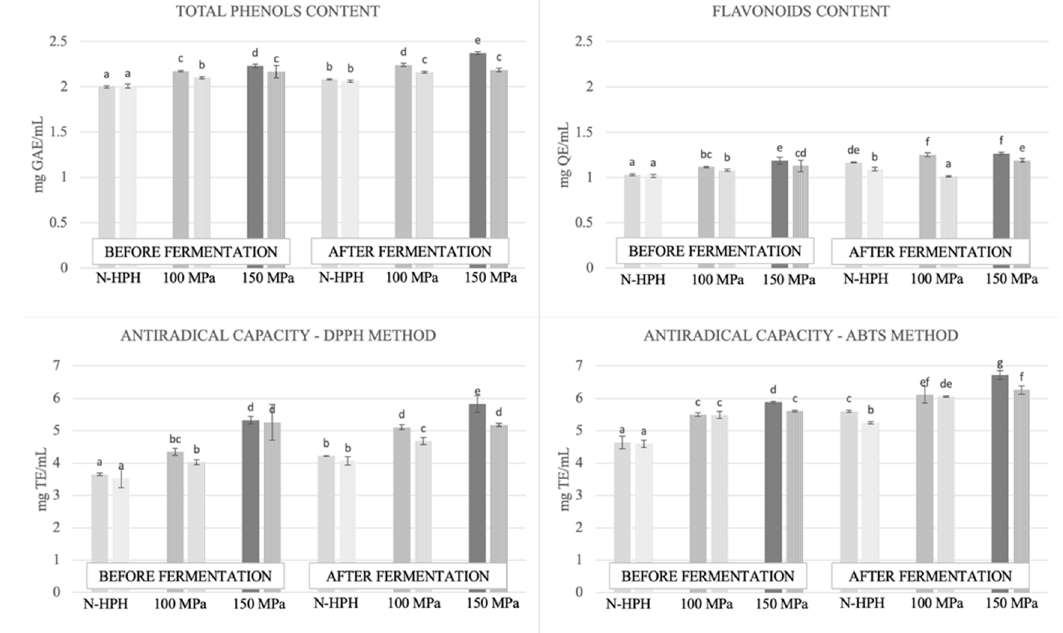
Figure 3. Total phenols content, flavonoids content, and antiradical capacity by DPPH and ABTS methods of the lulo juices before and after fermentation and as a function of homogenization pressure applied and pH. Solid bars represent juices at pH 5.5 and the striped bars represent juices at pH 6. Different letters denote statistically significant differences ( p ≤ 0.05).